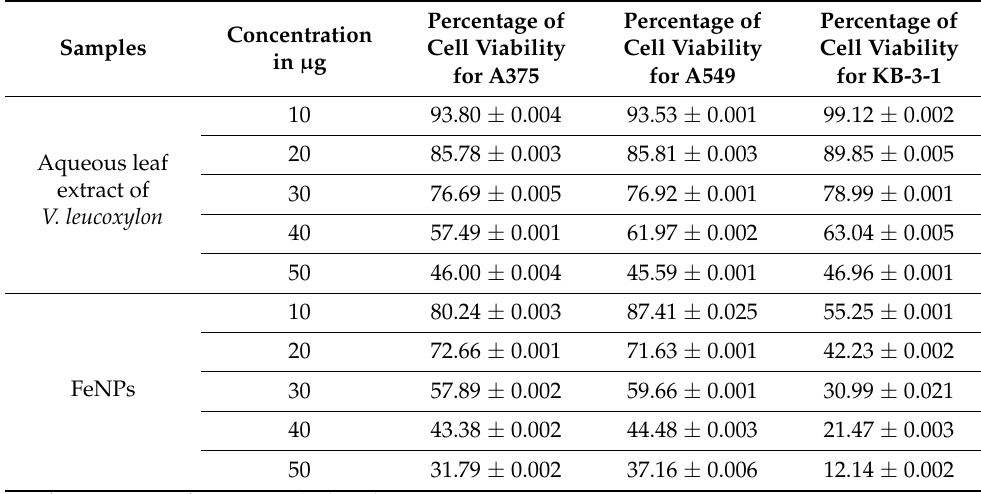
Table 8. Percentage of cell viability for aqueous leaf extract of V. leucoxylon and its synthesized iron nanoparticles against different cancer cell lines.